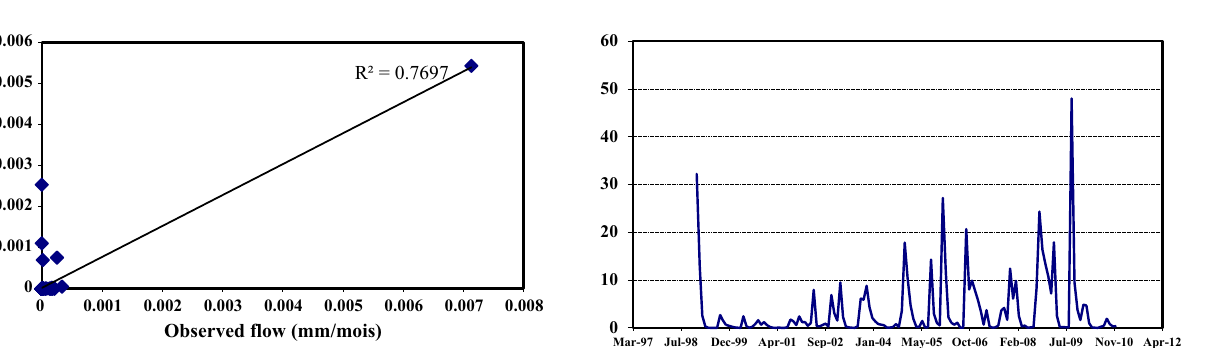
Fig. 5 Correlation between observed flows and simulated flows Fig. 6